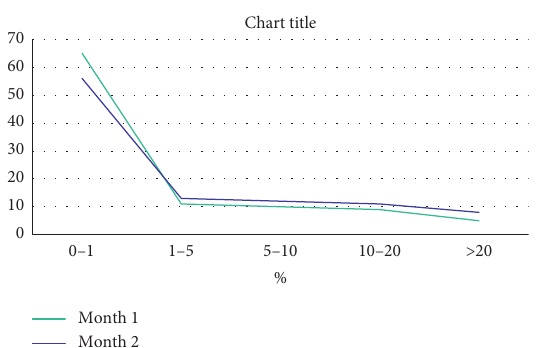
Figure 2: The bias pattern (mean) for all analytes over two consecutive months.